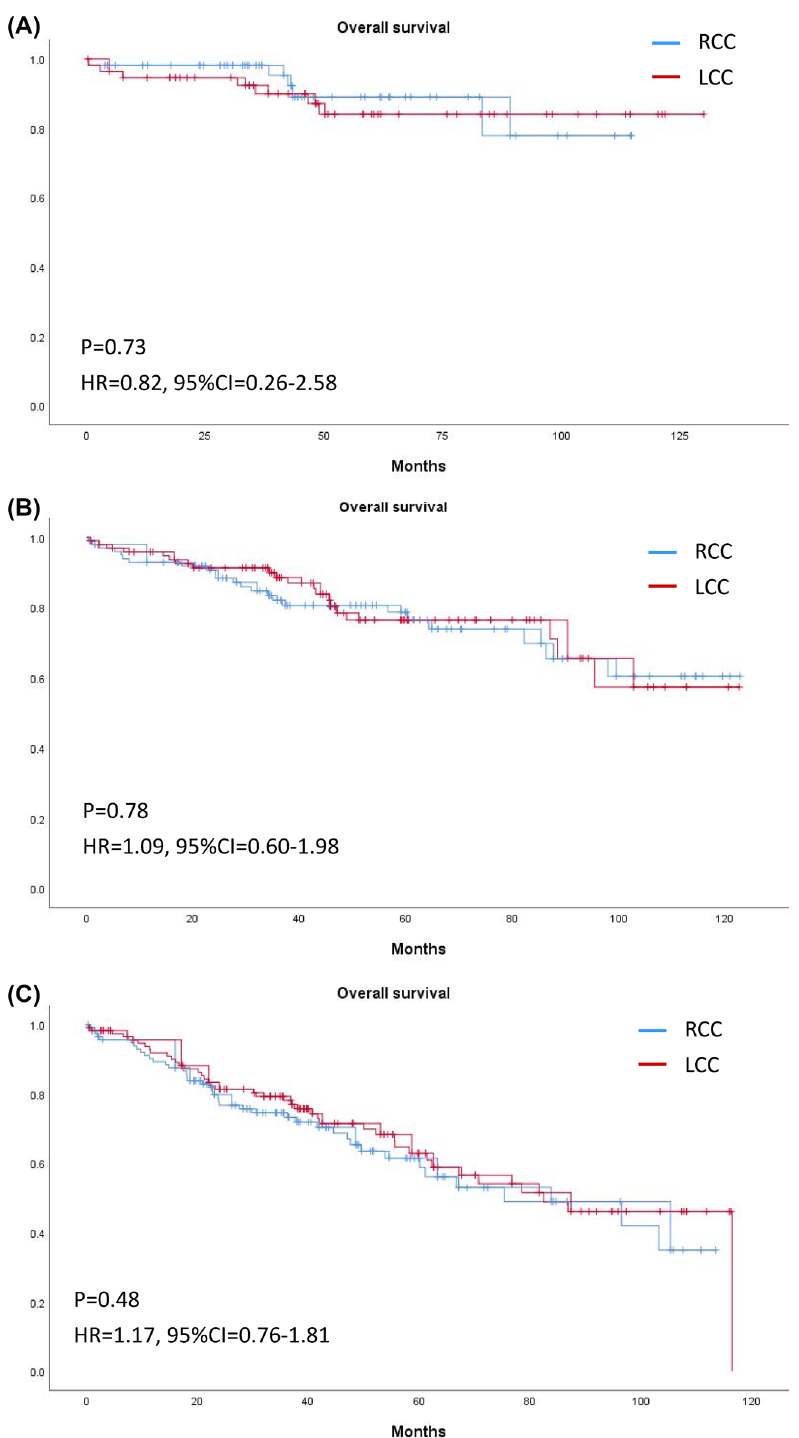
Figure 6. Kaplan–Meier curves of overall survival of right-sided and left-sided colon cancer in ( A ) Stage I, ( B ) Stage II, and ( C ) Stage III after